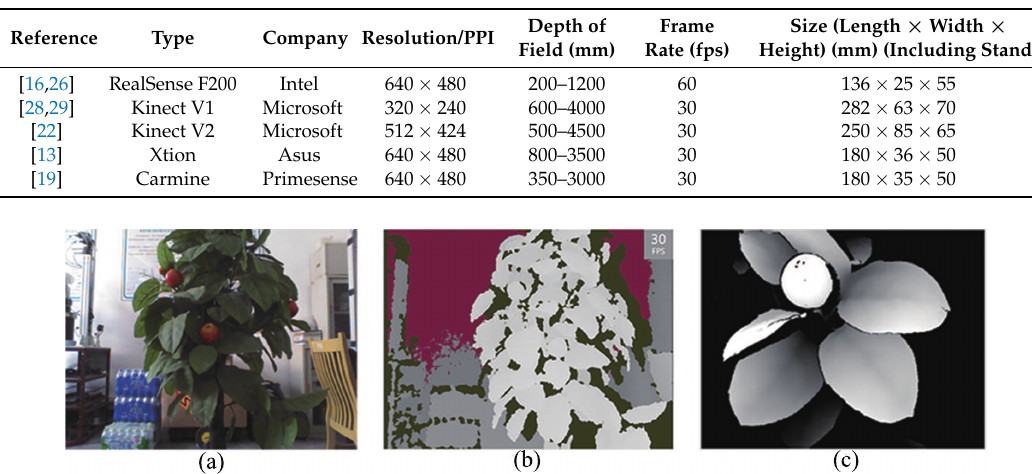
Figure 2. Comparison of depth images between Kinect and RealSense: ( a ) the real scene; ( b ) depth image captured with Kinect (distance: 0.9 m); ( c ) depth image captured with RealSense (distance: 0.3